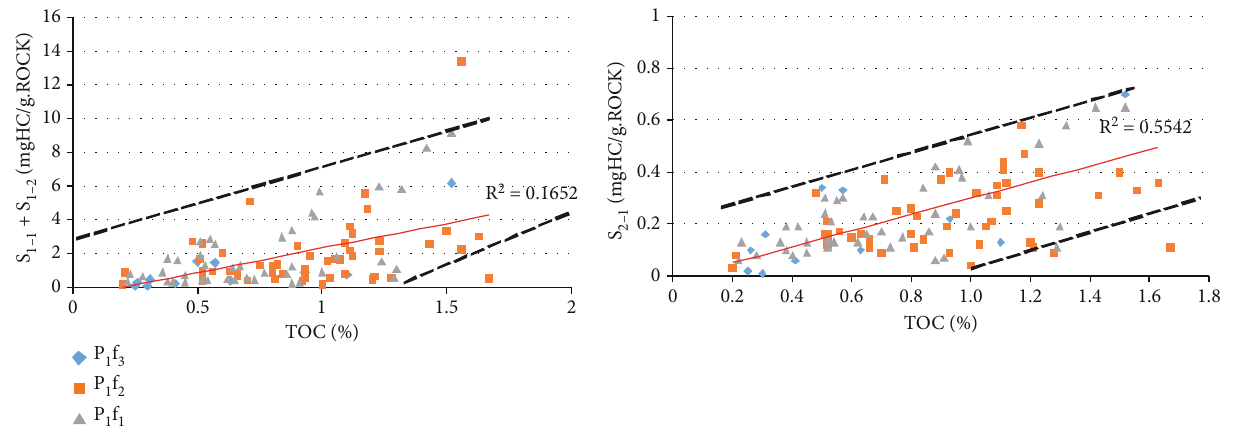
Figure 13: Relationship between free oil, adsorbed oil, and organic matter in the Fengcheng Formation